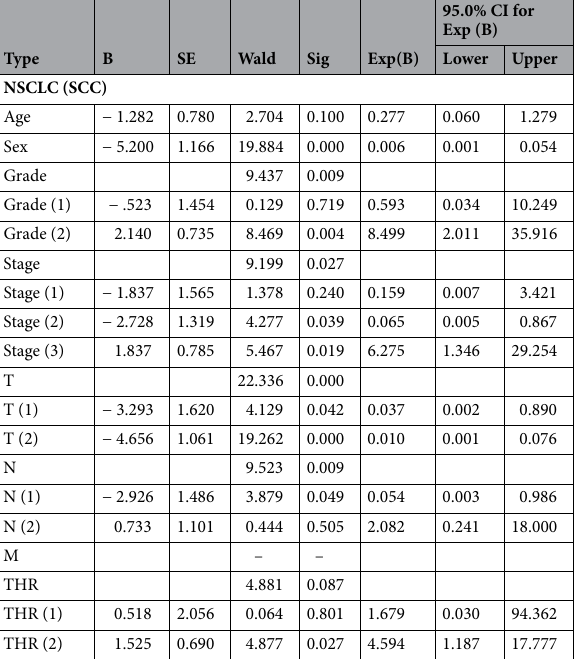
Table 4. Univariate Cox regression analysis of relationship between clinicopathological characteristics and prognosis in cases with NSCLC (SCC).